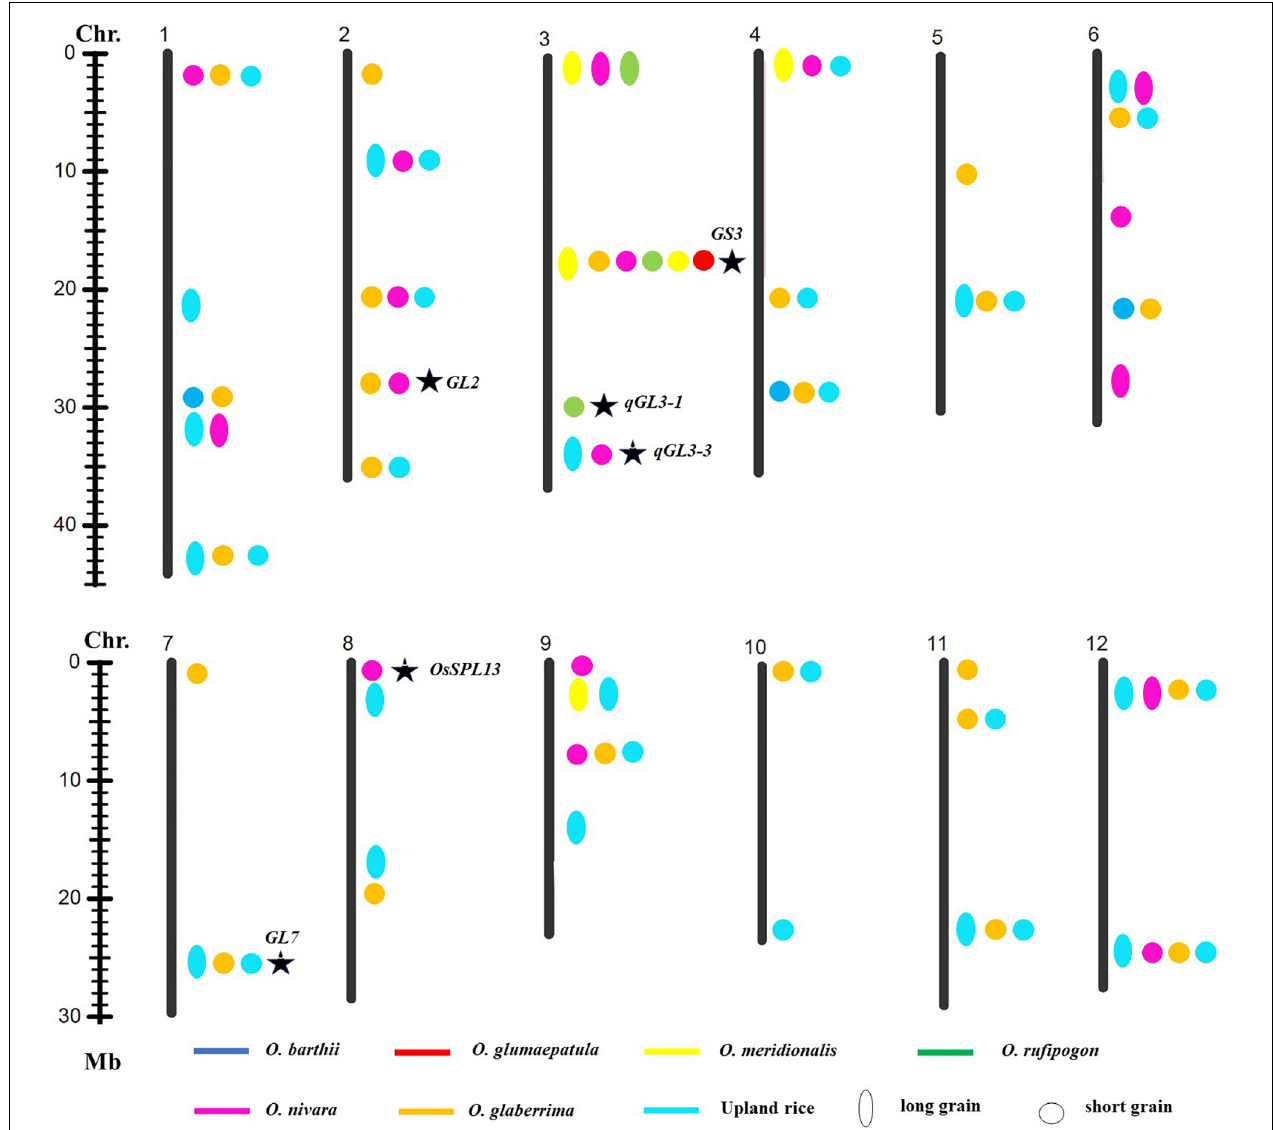
FIGURE 3 | Allelic variation linking with GL was detected from the different donors. Asterisk indicated published